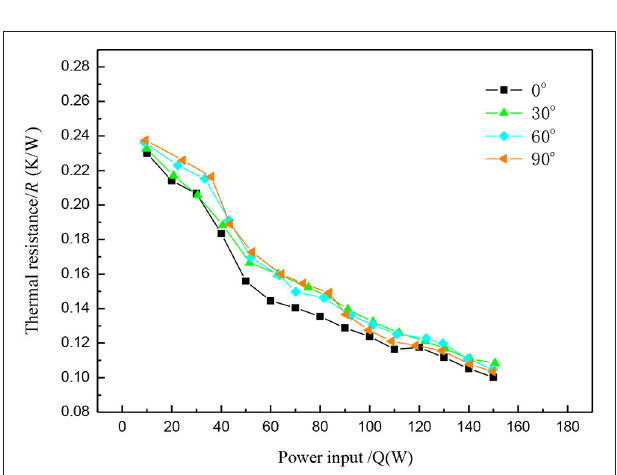
FIGURE 8 | Effect of the placement angle on the thermal